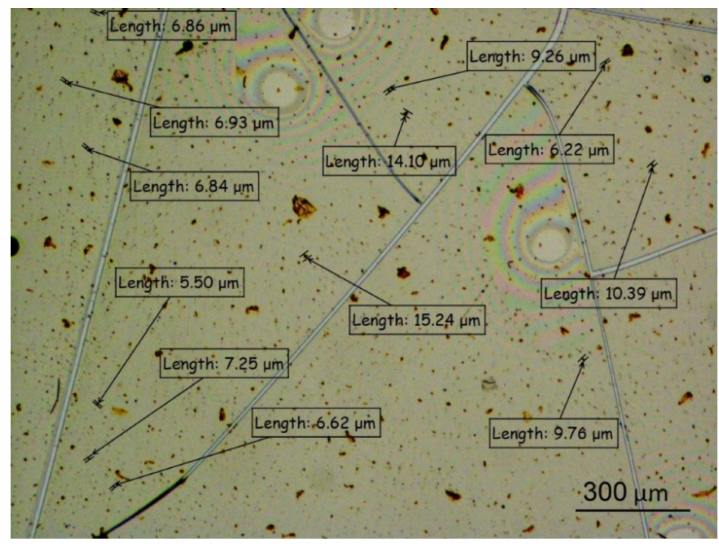
Figure 8. Photo of a dehydrated film obtained from an albumin solution (50 mg/mL) with the addition of MF at a concentration of 1 mg/L (center of the film).